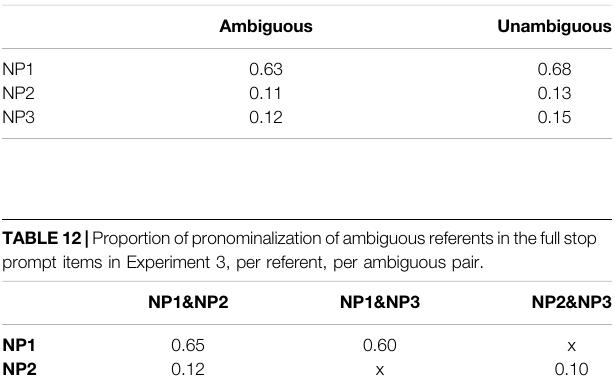
TABLE 11 | Proportion of pronominalization overall and for ambiguous vs unambiguous referents in Experiment 3 in the full stop prompt condition.